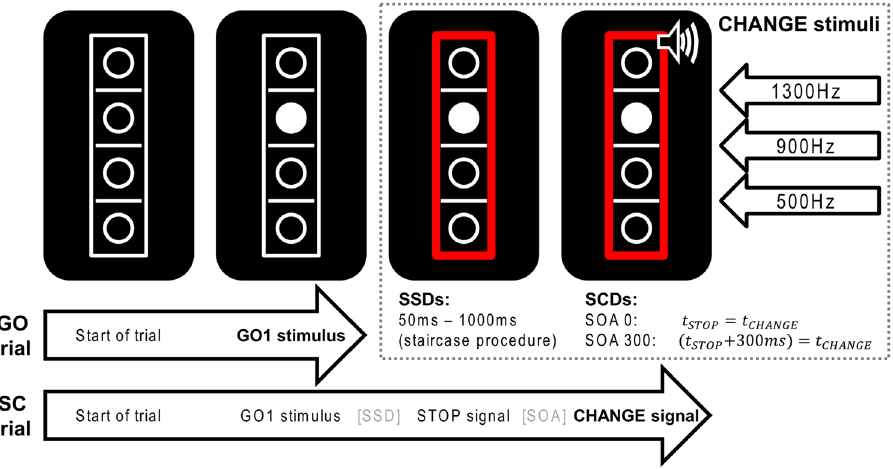
Figure 4. Stop-change paradigm: GO trials end after the first response to the GO stimulus, SC trials after a response to the CHANGE signal (bold). Delays between STOP (red rectangle) and CHANGE stimuli were 0 or 300 ms. Reference lines represent CHANGE